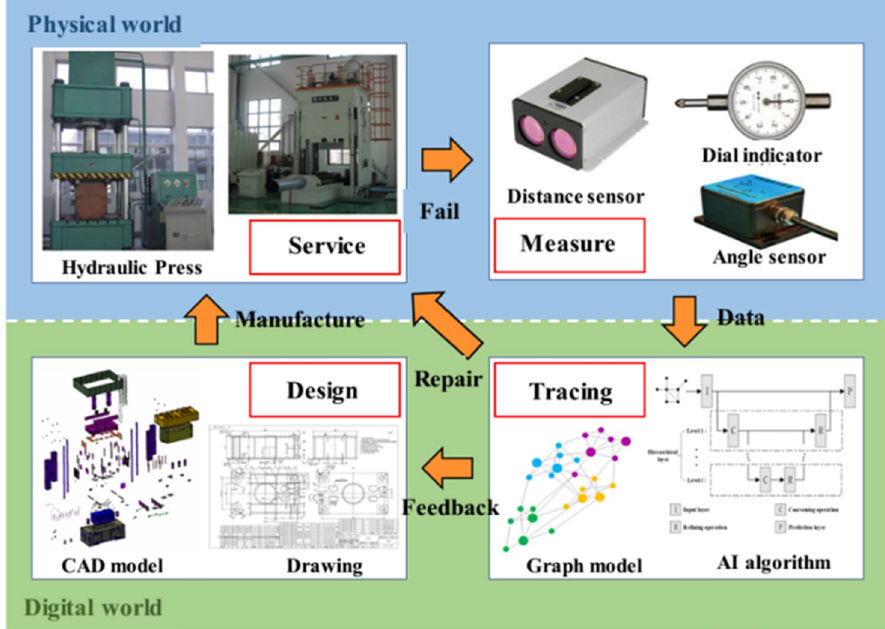
Figure 5. The framework of deviation